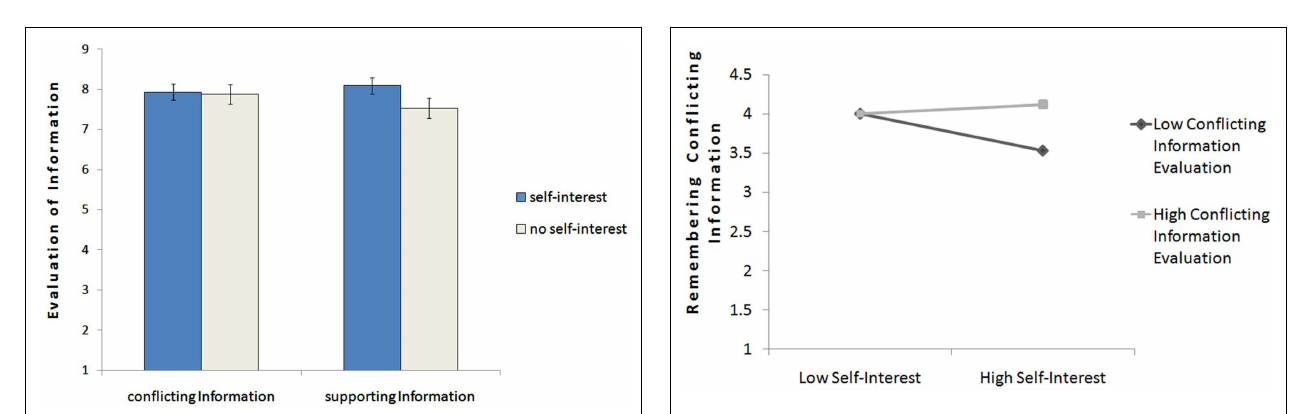
IMPLICIT STRATEGIES